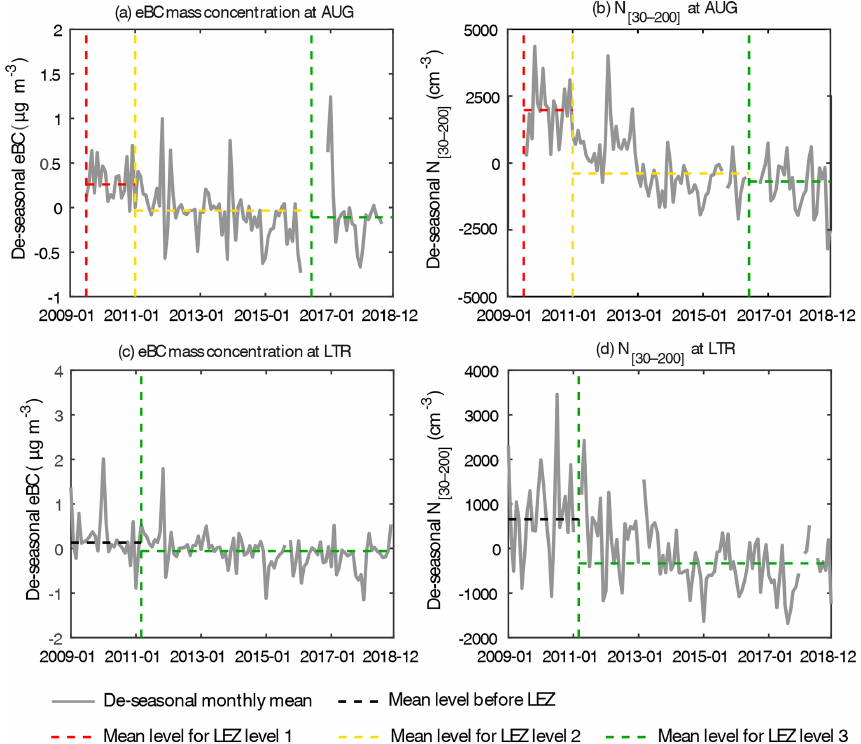
Figure 6. De-seasonalised monthly time series of eBC mass concentration and N [ 30 − 200 ] at the two urban background sites AUG and LTR. The vertical dashed lines refer to the start dates of different stages of LEZs in the city of Augsburg and Leipzig. The horizontal dashed lines refer to the mean concentration levels of measured parameters during the corresponding time